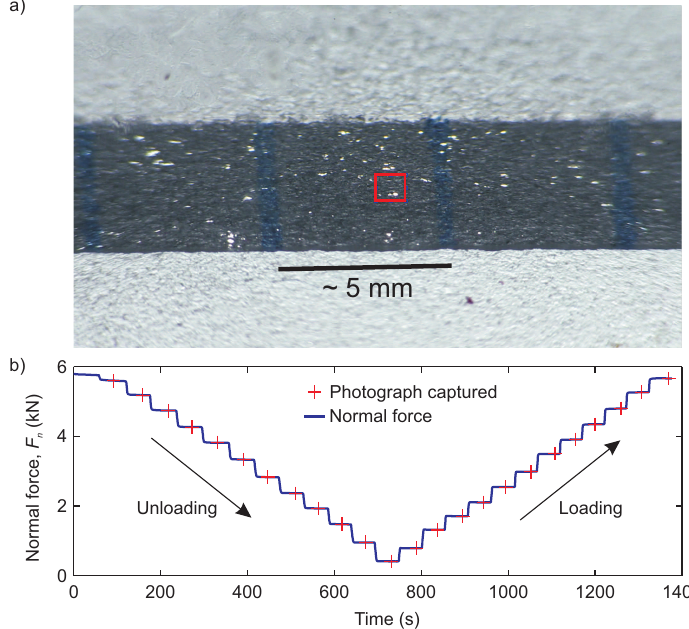
Figure 6. ( a ) An unprocessed image (2136 × 1362 pixels) from the video camera focused on the interface (darker region). Within the dark region are small bright regions that are asperities that transmit light more easily; ( b ) Test performed to measure the changes in light intensity and its relation to the applied normal force F n